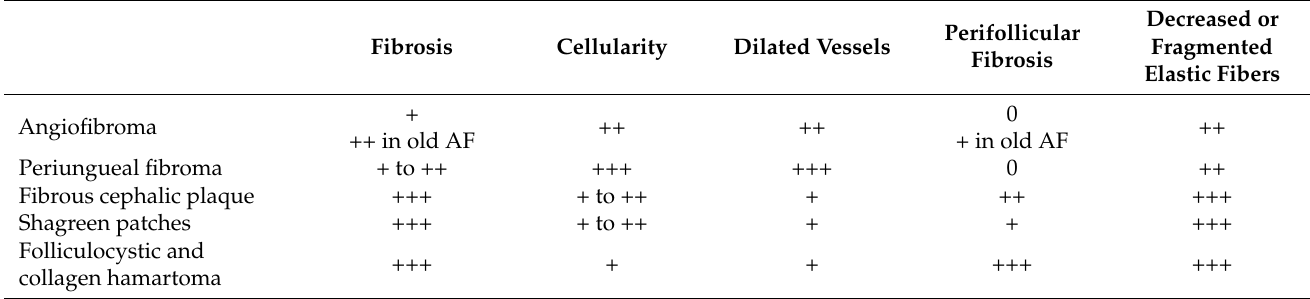
Table 2. Histopathological pattern of TSC cutaneous hamartoma. Decreased or Perifollicular Fragmented Fibrosis Cellularity Dilated Vessels Fibrosis Elastic Fibers